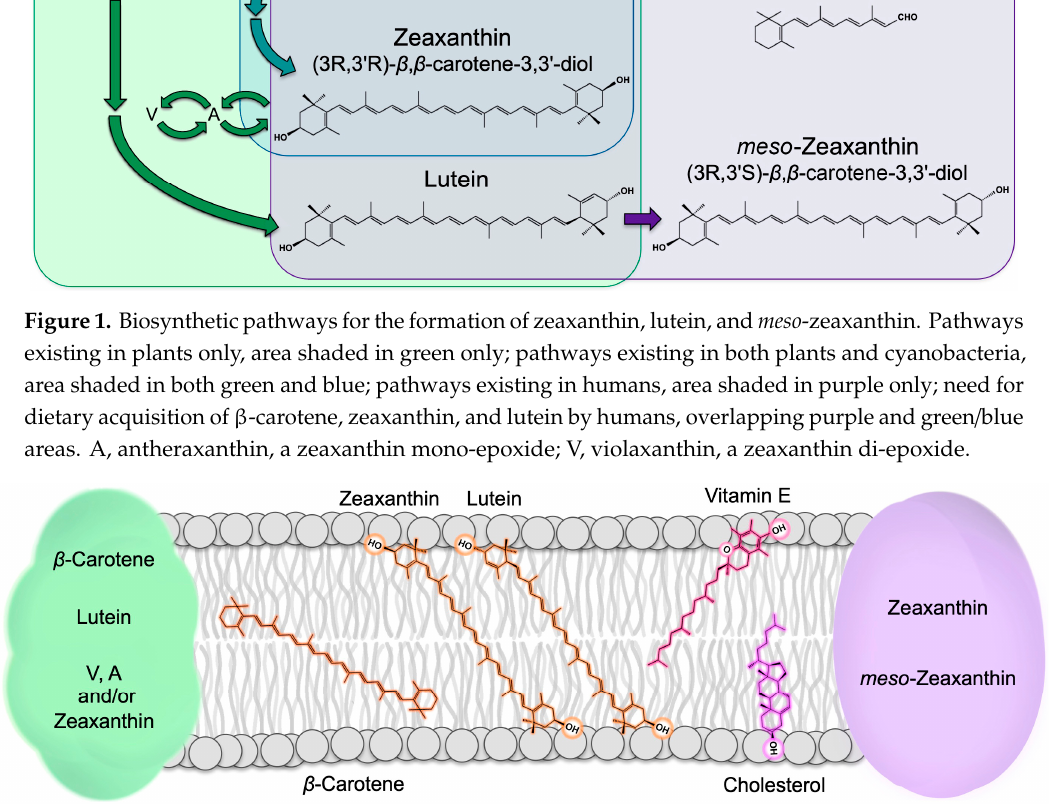
Figure 1. Biosynthetic pathways for the formation of zeaxanthin, lutein, and meso -zeaxanthin. Pathways existing in plants only, area shaded in green only; pathways existing in both plants and cyanobacteria, area shaded in both green and blue; pathways existing in humans, area shaded in purple only; need for dietary acquisition of β -carotene, zeaxanthin, and lutein by humans, overlapping purple and green/blue areas. A, antheraxanthin, a zeaxanthin mono-epoxide; V, violaxanthin, a zeaxanthin di-epoxide.